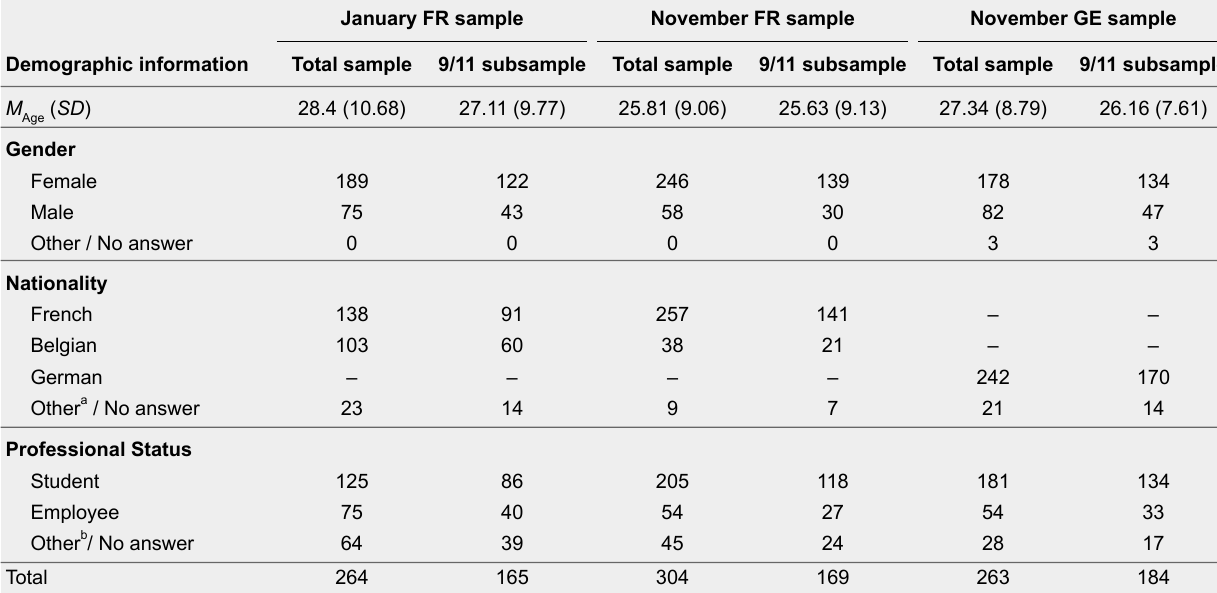
Participants’ Characteristics in Each of the Three